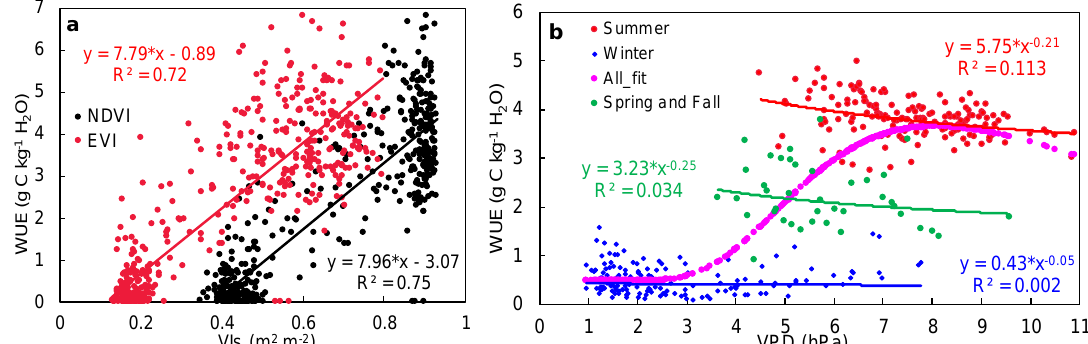
Figure 4. Scatterplots between WUE and ( a ) VIs (WUE is indirectly estimated by flux observation. NDVI and EVI are calculated by MODIS reflectance products. GPP and ET data at 8-day time scale are averaged from daily observed data of FLUXNET (https://fluxnet.org/. Accessed on 15 January 2020)). Three temperate broadleaf forest sites, i.e., IT-Col, US-MMS and US-UMB are selected. The black and red lines represent the linear trend between WUE and EVI, and NDVI, respectively), and ( b ) VPD (The data are based on daily mean values of US-MMS site from 2000–2014. The pink curve indicates the resulted fitting equation, i.e., y = a ∗ x b + x c + d using daily data for the whole year. Winter and summer respectively represent the non-growth and growth periods, whereas spring and autumn respectively represent the emergence and senescence periods. The phenological information is determined by the rate of change in slope for the fitted curve’s double logistic function to the WUE time series).